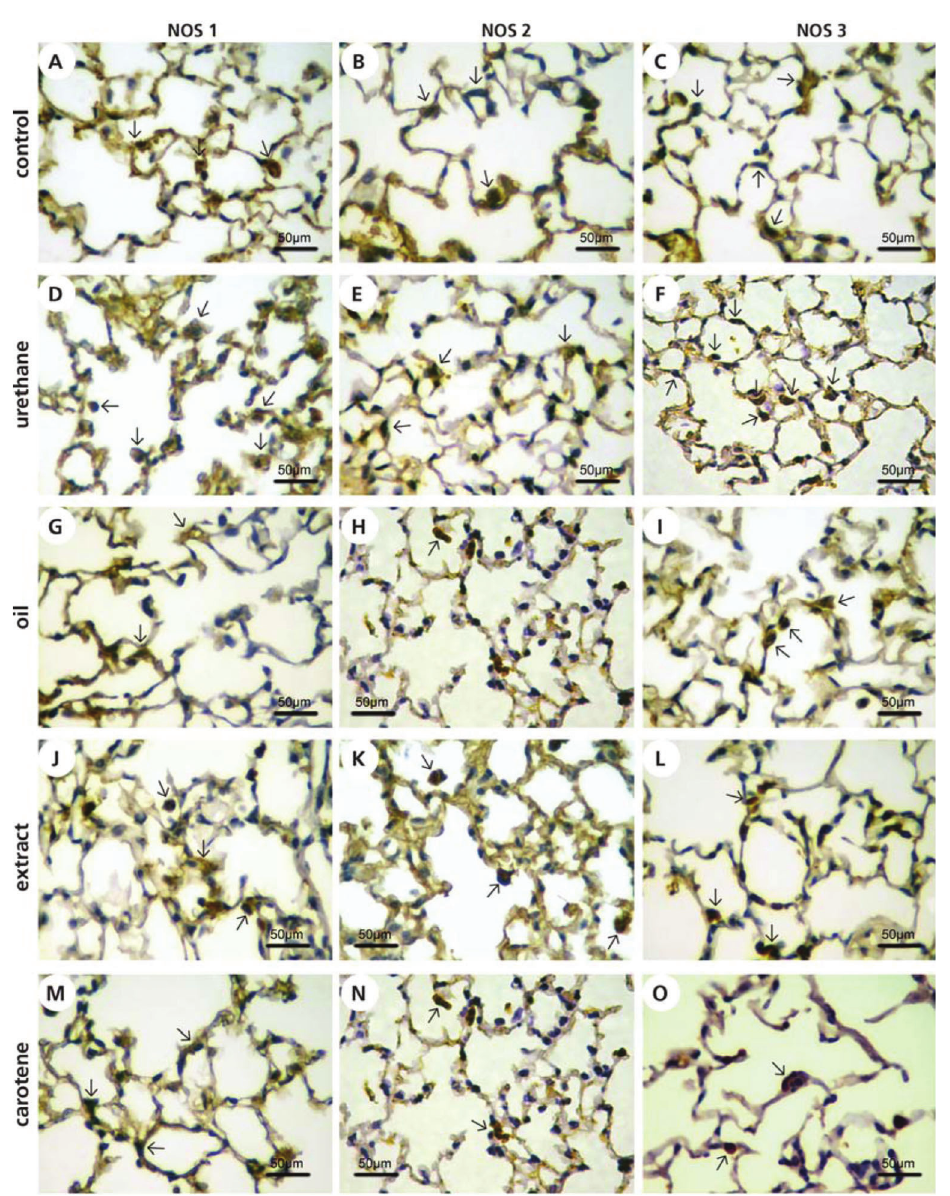
Figure 5. Immunostaining for NOS1, 2, and 3. Representative NOS-stained sections of lung tissue specimens from control, urethane- injected, and supplemented mice are shown. A - C , Few alveolar epithelial cells (arrows) in control mice express NOS1, 2, or 3. D - F , Numerous alveolar epithelial cells (arrows) in urethane-injected mice express NOS1, 2, or 3. G - O , Alveolar epithelial cells (arrows) in antioxidant-supplemented mice with reduced expression of NOS1, 2, and